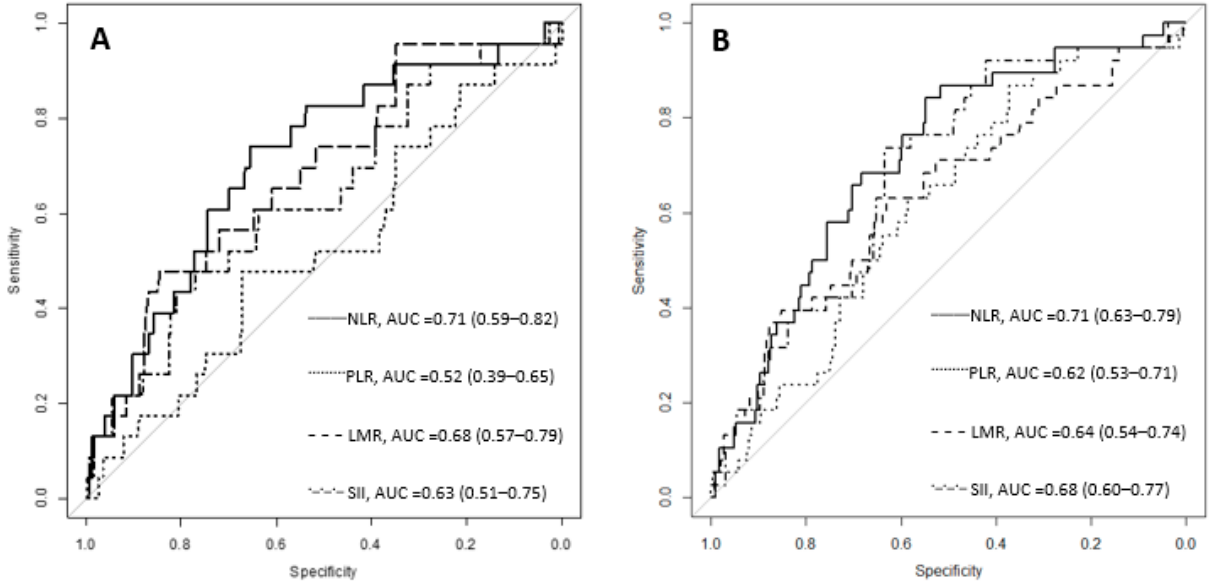
Figure 3. The ROC curves for inflammatory ratios considering death during the hospitalization period ( A ) and surgical complications ( B ). NLR = neutrophil-to-lymphocyte ratio; PLR = platelet-to- lymphocyte ratio; LMR = lymphocyte-to-monocyte ratio; SII = systemic immune-inflammation index; AUC = area under the curve, with 95% confidence intervals.